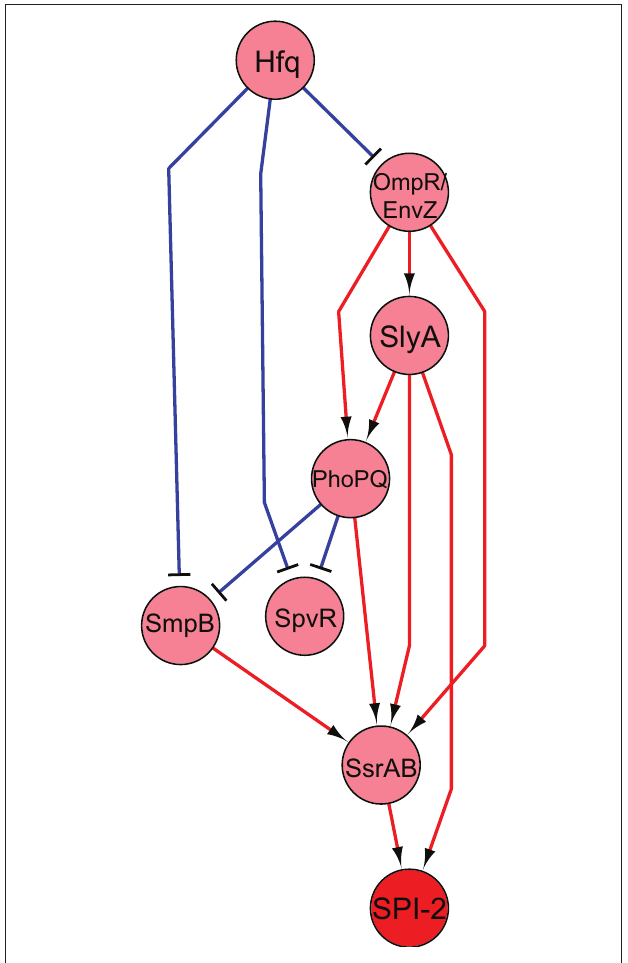
FiGuRe 2 | Regulatory network of selected transcription factors essential for virulence. Regulators essential in systemic infection were deleted and microarray expression data under SPI-2 inducing conditions were used to construct a regulatory network. The figure shown represents a selected subset of all the regulators examined (see Yoon et al., 2009 for the complete network). The nodes indicate regulators, with the red node indicating the SPI-2 genes. Edges indicate activation (red) or repression (blue). Predictions made by this model were validated experimentally (Yoon et